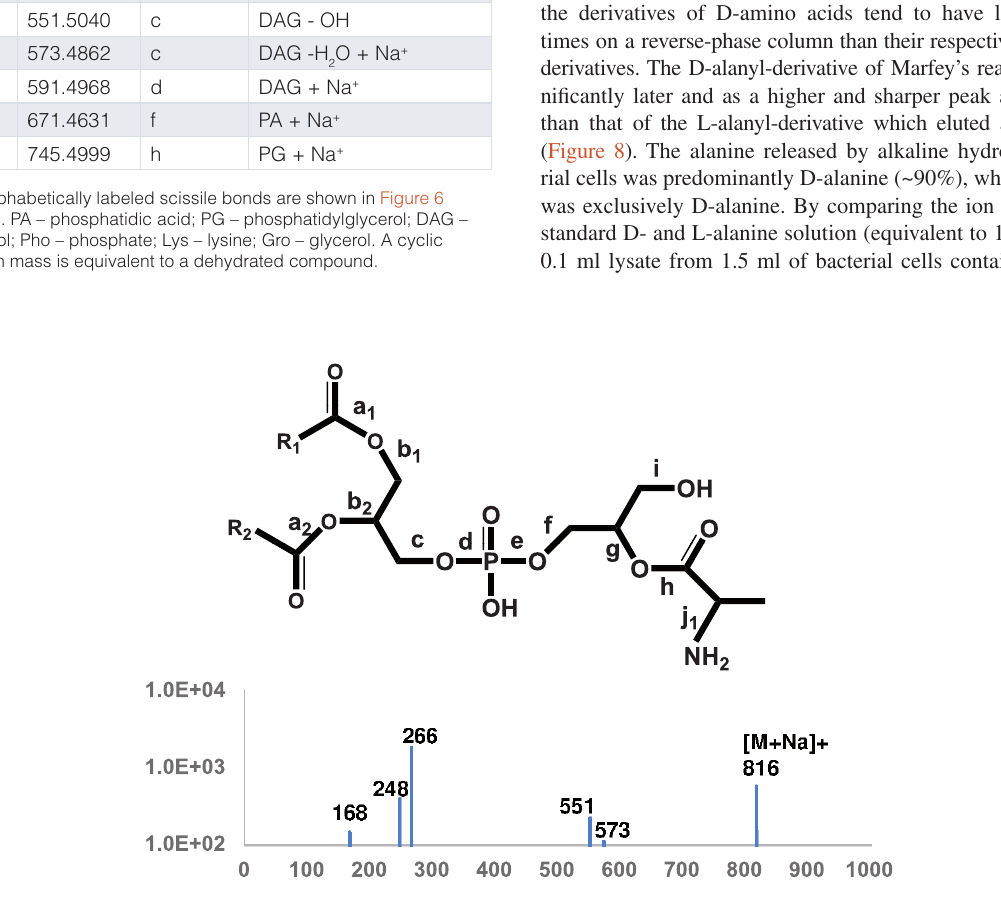
Figure 7. Tandem MS spectrum of (32:0) alanyl-PG. MS/MS spectrum of sodiated alanyl-PG (816 amu) ions is shown. The molecular structure is shown on the top with scissile bonds labeled alphabetically. The horizontal axis represents m/z values. The vertical axis represents ion